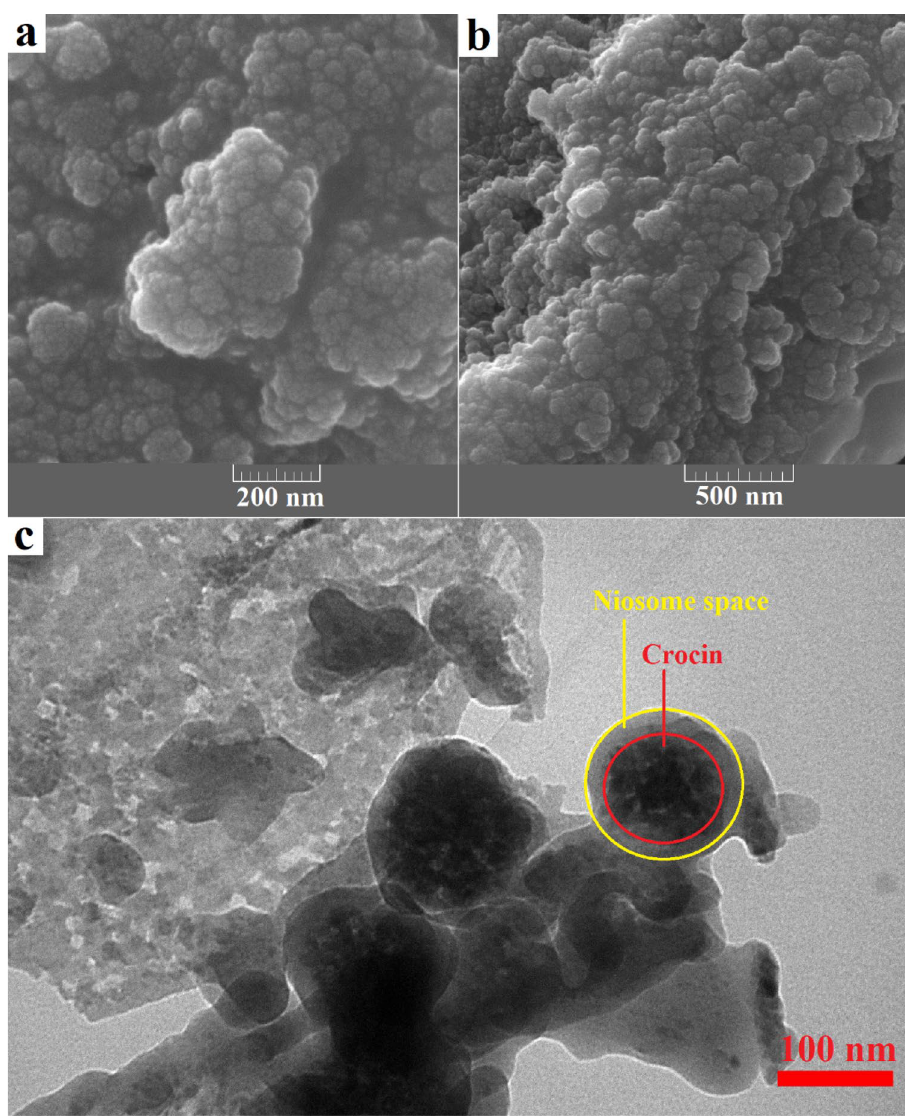
Figure 1. SEM images of the niosomal formulation contain crocin at scale 200 nm ( a ), scale 500 nm ( b ) and TEM image ( c